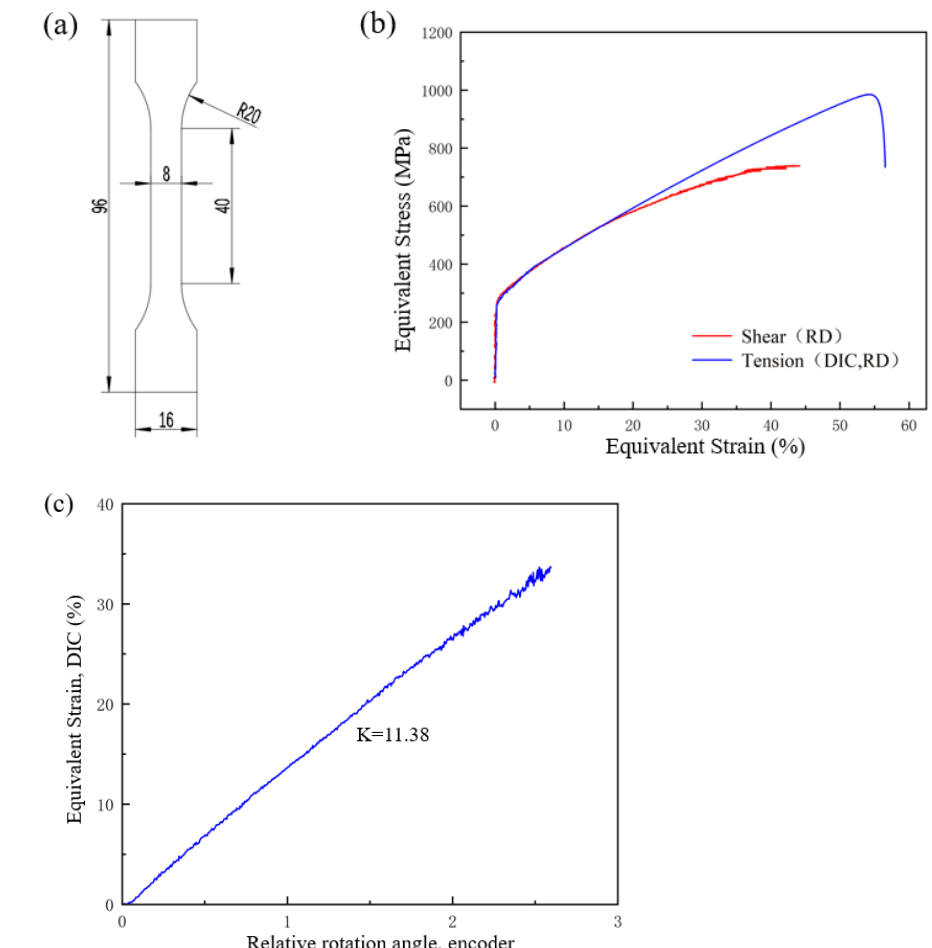
Figure 3. ( a ) Specimen geometry in monotonic tensile test, ( b ) comparison of tensile and shear, ( c ) relationship between equivalent strain and rotation angle.